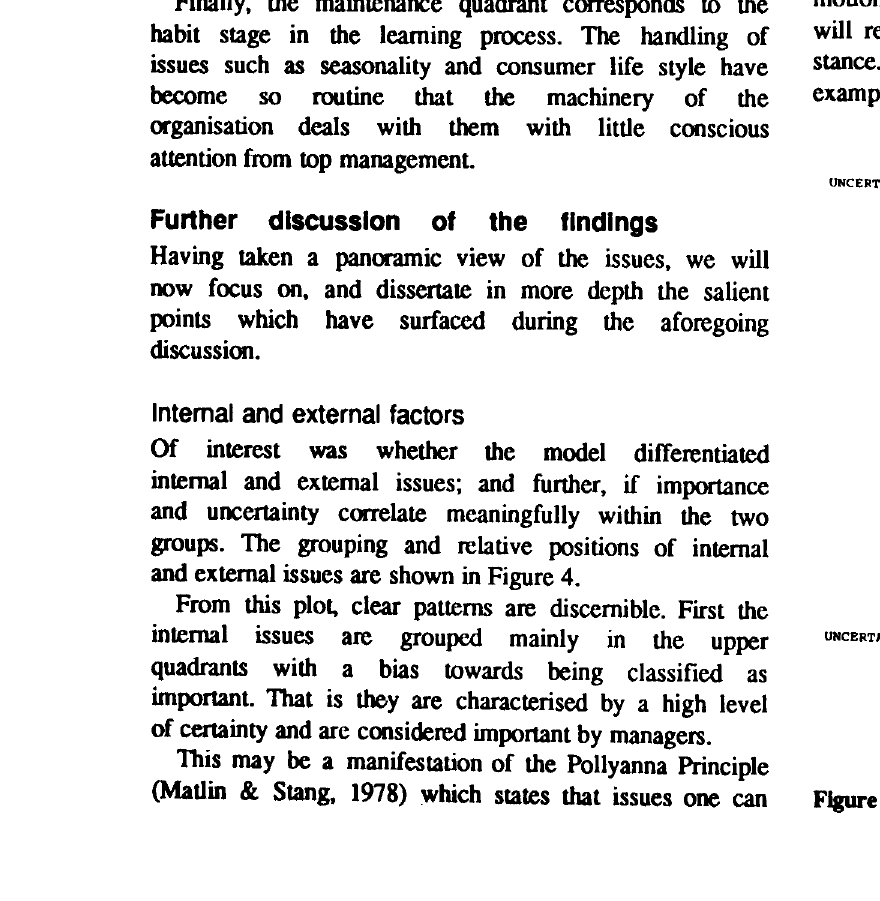
Figure 4 Relative position of internal and external